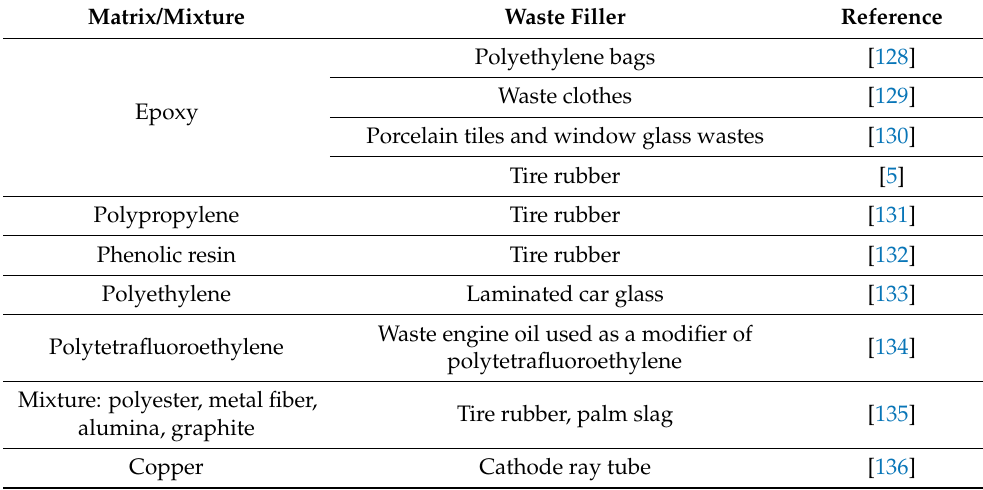
Table 3. Polymer and metal matrix composites reinforced with postconsumer waste